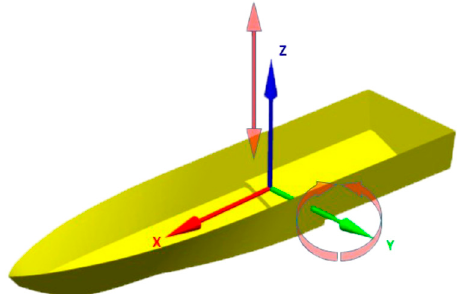
Figure 2. Local coordinate system of planing hull motion solver.